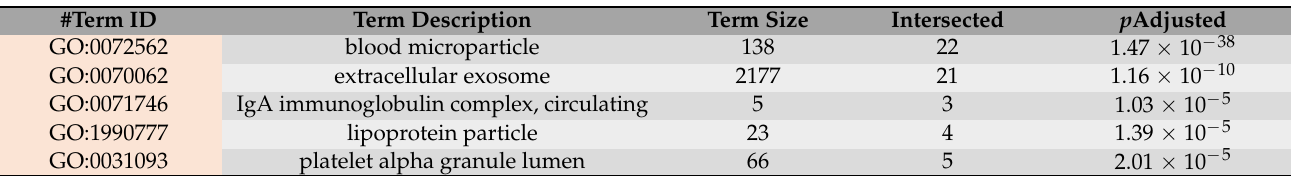
Table 4. GO Cell Component analysis of molecules enriched in SEC3 vs. SEC8 preparations. Red color denotes enrichment in SEC3